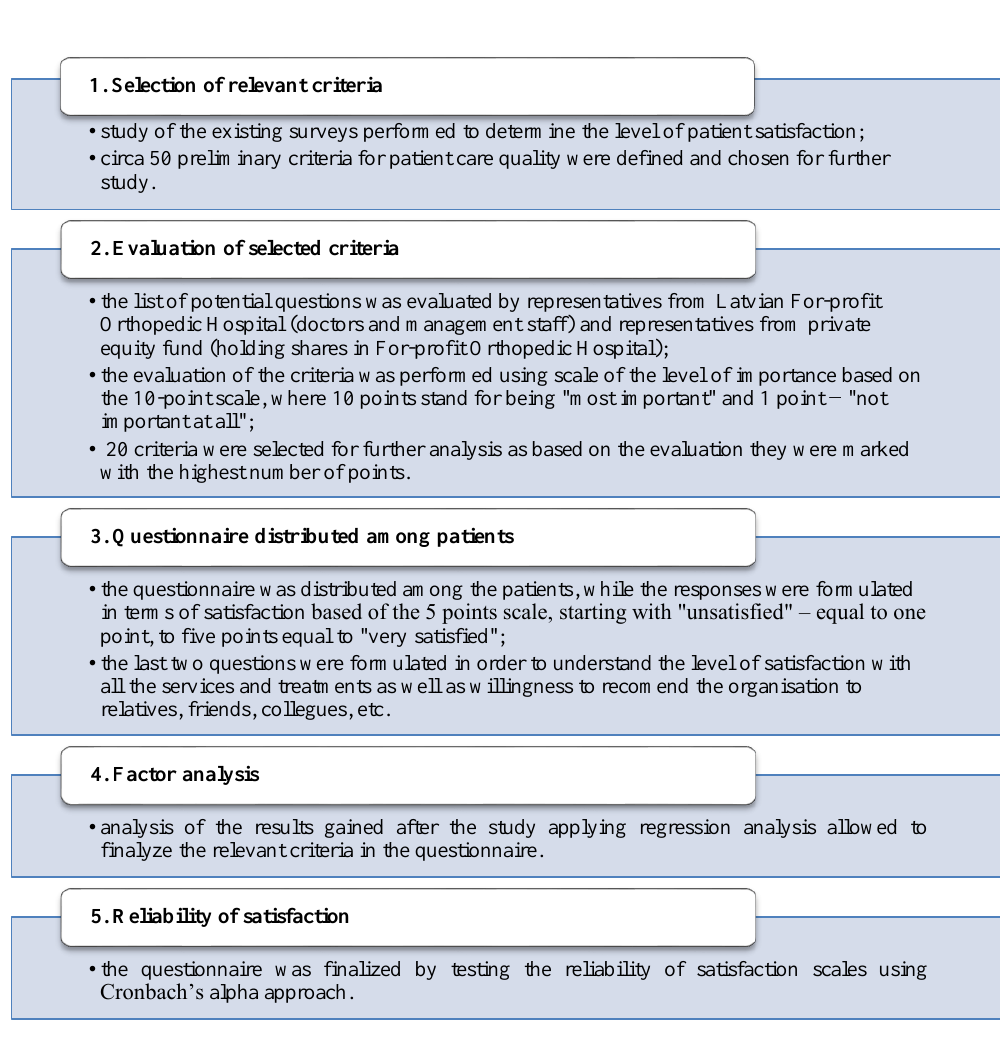
Fig. 1. Methodological Approach (created by author and based on the studies mentioned